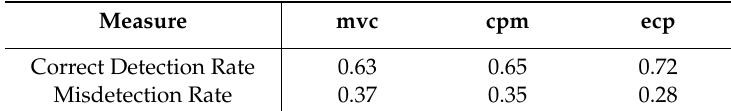
Table 4. Accuracy of